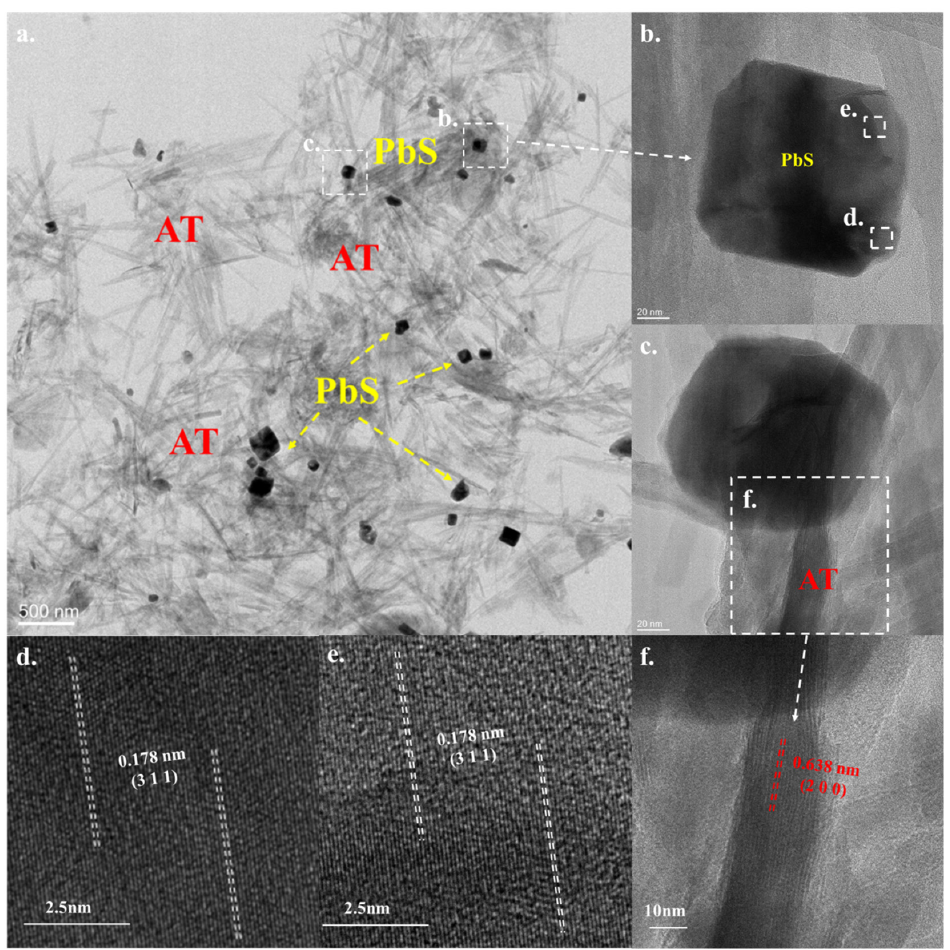
Figure 5. TEM (Transmission Electron Microscope) result ( a – c ) and HRTEM (High Resolution Transmission Electron Microscope) images ( d – f ) of AT@PbS (attapulgite/lead sulphide composite).